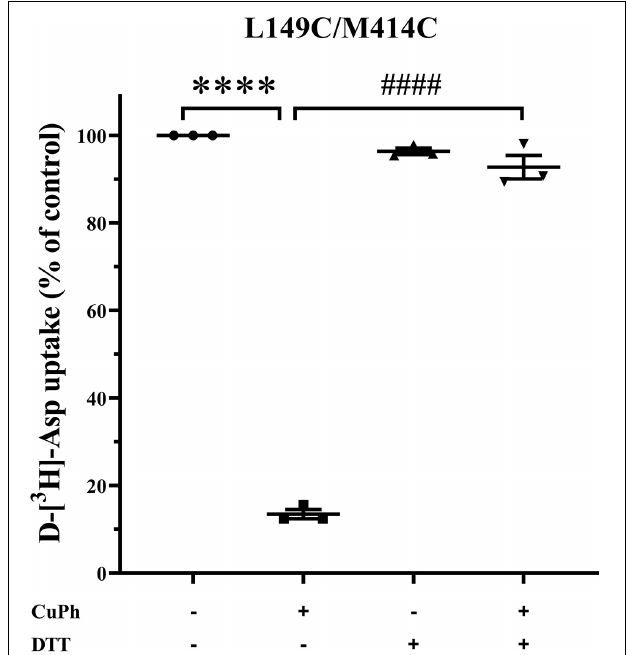
FIGURE 4 | Effects of outer medium on CuPh-induced inhibition in L149C/M414C double mutants. HeLa cells expressing the indicated double mutants were treated with 100 µ M CuPh mixed with different mediums (150 mM NaCl solution, NaCl solution + 1 mM L-glutamate, NaCl solution + 20 µ M TBOA, 150 mM KCl solution, and 150 mM choline chloride solution). D-[ 3 H]-aspartate uptake was assayed for 10 min. Values are given as a percent of control (pre-incubation without CuPh). Data are the means ± S.E. representative of at least three separate experiments in triplicate. Values significantly different from L149C/M414C treated with 100 µ M CuPh in NaCl solution were determined by one-way ANOVA ( ∗ p < 0.05; ∗∗∗ p < 0.001; n =